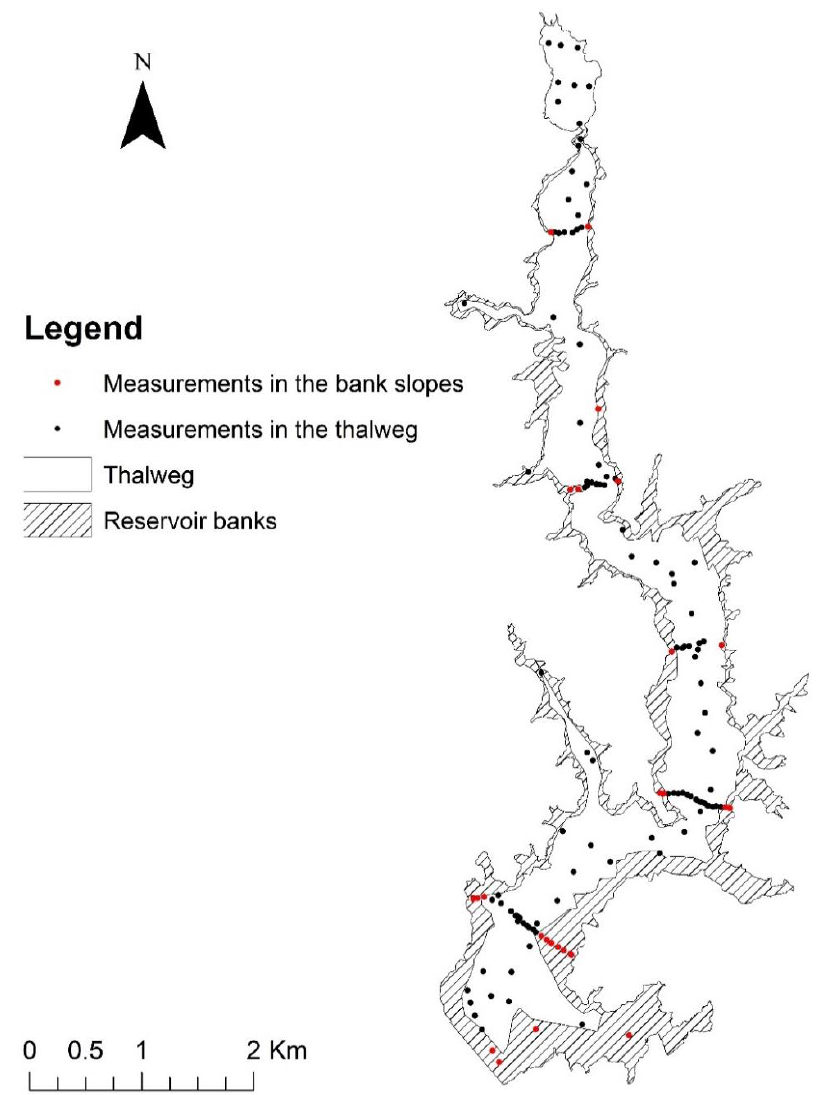
Figure 23. Division of the reservoir into compartments for the calculation of a representative averaged sediment thickness of the reservoir via the GP.